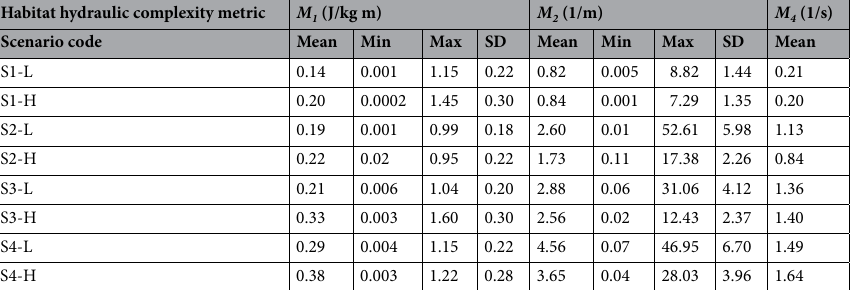
Habitat hydraulic complexity